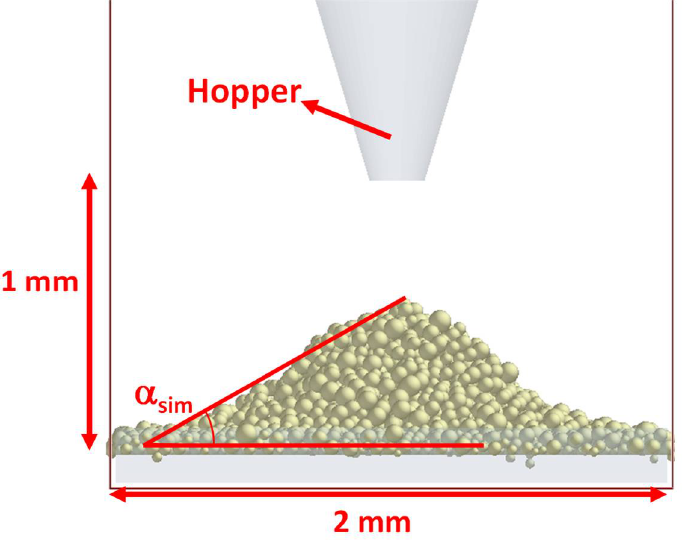
Figure 3. Simulation of the angle of repose test, where α sim is the static angle of repose from the simulation.